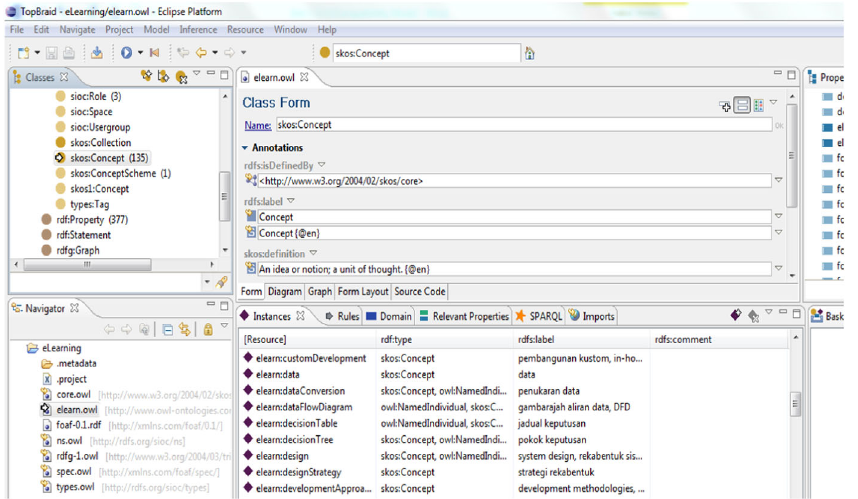
Figure 5. Ontology